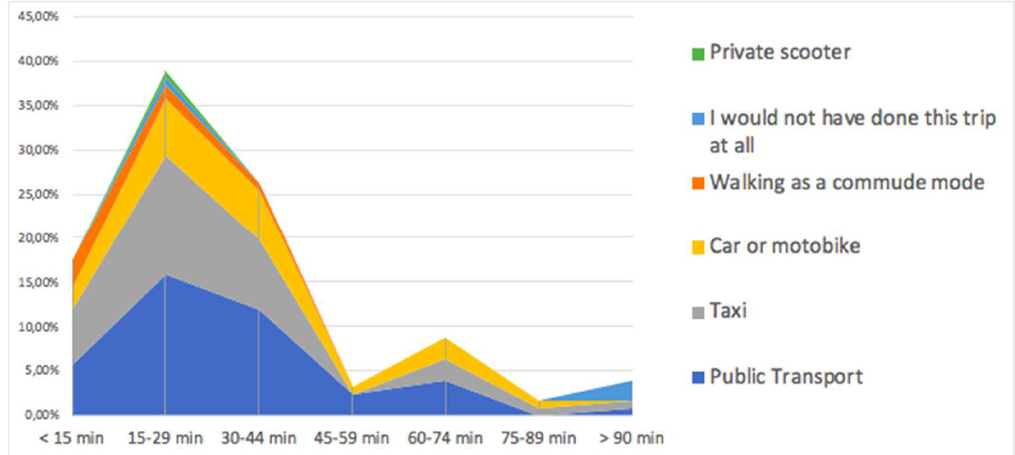
Figure 6. The last TNC trip: frequency of duration and alternative modes (N = 311, % of all TNC users).